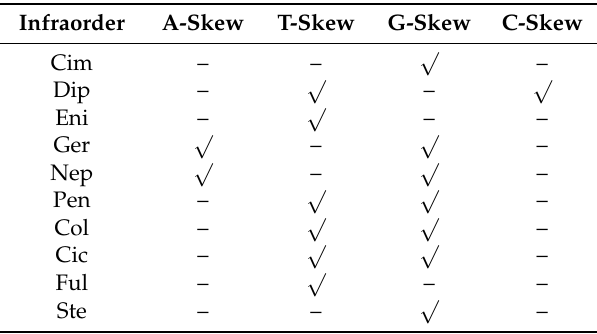
Table 2. Skew patterns among infraorders in the Hemiptera.